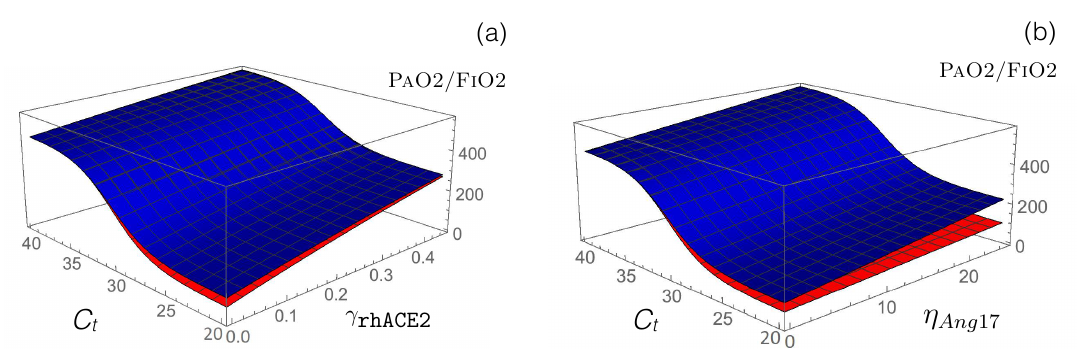
Figure 5. Impact on the P A O2/F I O2 value of the administration of rhACE2 and Ang1-7 in normotensive (blue) and hypertensive (red) SARS-CoV-2 patients. ( a ) Predicted P A O2/F I O2 values as a function of C t and γ rhACE2 . ( b ) Predicted P A O2/F I O2 values as a function of C t and η Ang 17